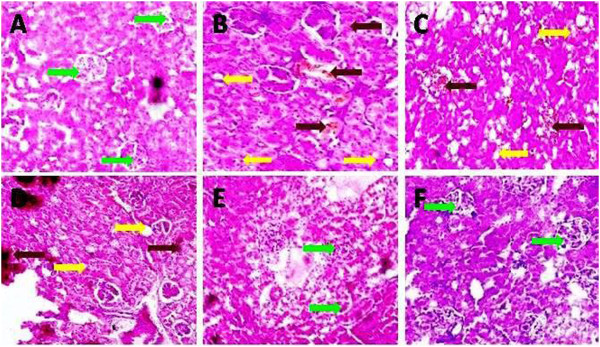
Paederia Foetida Linn. leaves extract effect on kidney histopathology in normal and STZ induced diabetic rats. (A) Normal control: Normal control group rat histopathology shown normal size of glomerulus and bowman capsule (Green arrow) (B) Diabetic control: Diabetic control group rat histopathology display the inflamed blood vessels (Red arrow), bigger size of bowman capsule, glomerulus and fat deposition (Yellow arrow) (C)PF I (100 mg/kg): PF tested drug histopathology display the inflammation in blood vessels (brown arrow), bigger size bowman capsule and fat deposition (yellow arrow) (D)PF II (250 mg/kg): PF treated drug group rat histopathology display fat deposition (yellow arrow) and inflammatory blood cells (Red arrow). (E)PF III (500 mg/kg): PF treated group display the normal histopathology only increase the size of bowman capsule (green arrow). (F) Glibenclamide (10 mg/kg): Histopathology of glibenclamide treated group rat display the normal kidney but bowman capsule bigger in size (Green arrow). The samples were obtained from the same liver anatomical regions. For each group, 6 rats were examined and 50 pictures were taken. Original magnification, 10×.